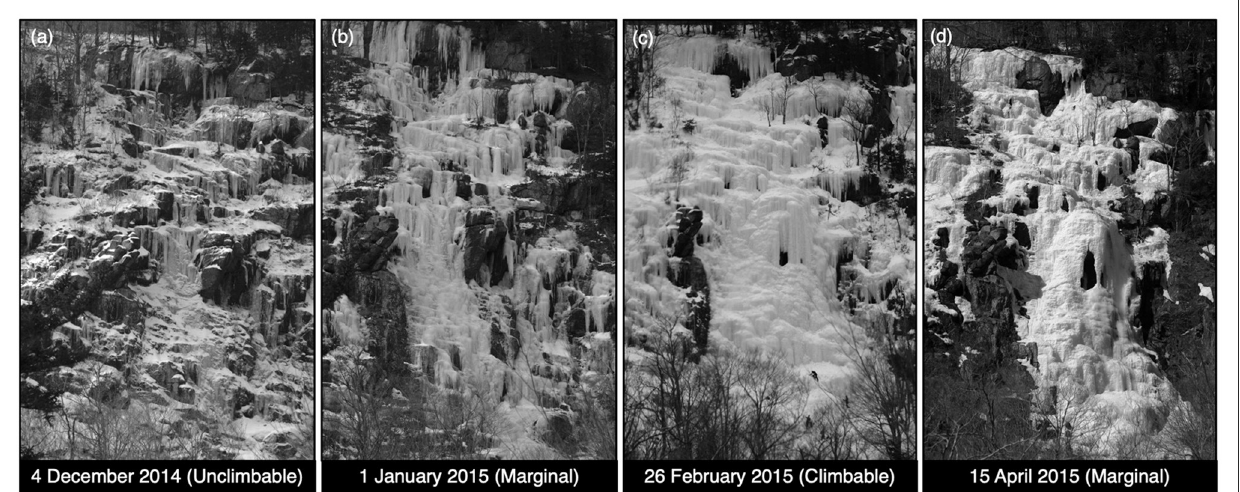
FIGURE2 A typical pattern of ice growth and decay through a season, with assigned ratings in parentheses (photos by Al Hospers). (a) Ice begins building as temperatures drop in the early season. This was rated “Unclimbable” because the ice is thin with visible gaps, and the top of the climb is discontinuous. (b) Groundwater and thaw-freeze of snow provides water for climbs to continue building. As it runs over ice, channels form creating preferential flow paths. This was rated “Marginal” because while it is climbable, the volume of ice would likely be unclimbable after a week of warm temperatures. (c) Combined cold and water cause the ice to grow to substantial volumes by mid-season. Climber visible in bottom right of photograph. This was rated “Climbable” because the ice is thick and well filled-in. (d) As temperatures warm above freezing and solar radiation increases during the spring, ice climbs melt. This was rated “Marginal” because the ice, while thick enough to protect, shows substantial signs of decay. The potential for ice fall and collapse is higher during the spring, and climbers may face increased hazards if choosing to climb during this time. The decision to rate this “Marginal” vs. “Unclimbable” is an example of the subjective and experientially informed risk-based decision-making ice climbers engage